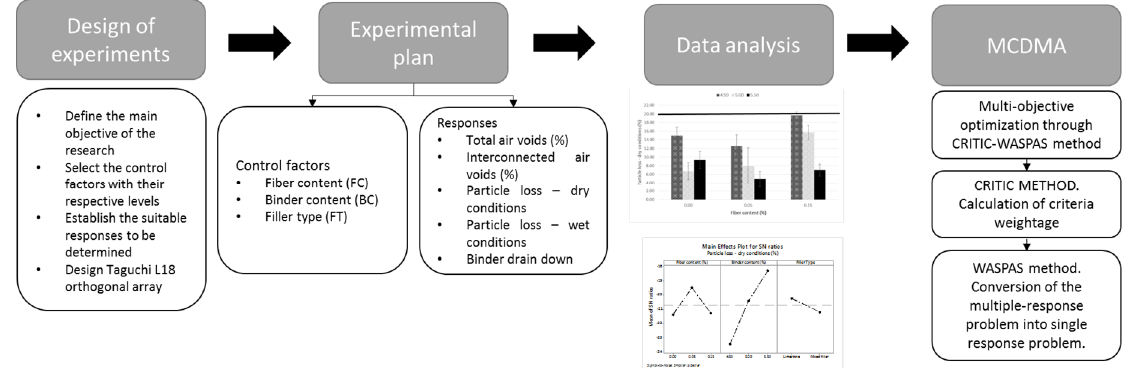
Figure 2. Structured framework of the current research.